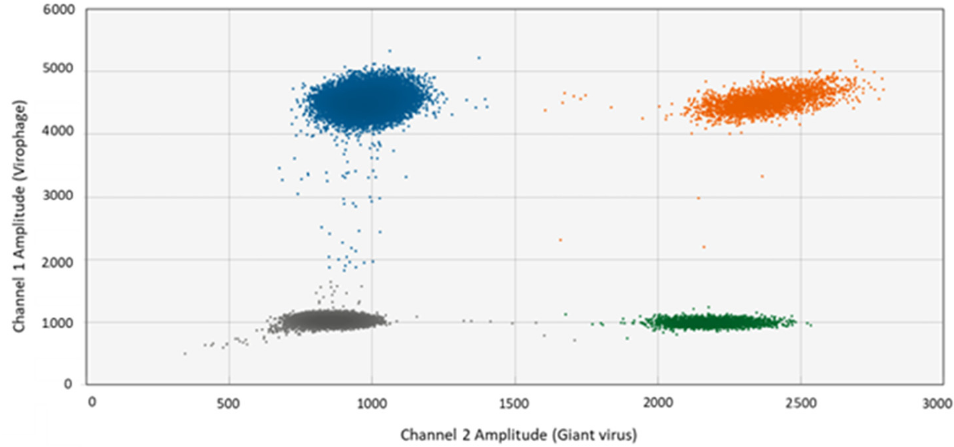
Figure 2. 2D-scatter plot of a multiplex ddPCR experiment containing giant virus and virophage templates with their primers and probes (see Figure 1e,f). Channel 1 shows FAM fluorescence (virophage, blue) and Channel 2 shows HEX fluorescence (giant virus, green). Double negatives are shown in grey, double positives in orange.